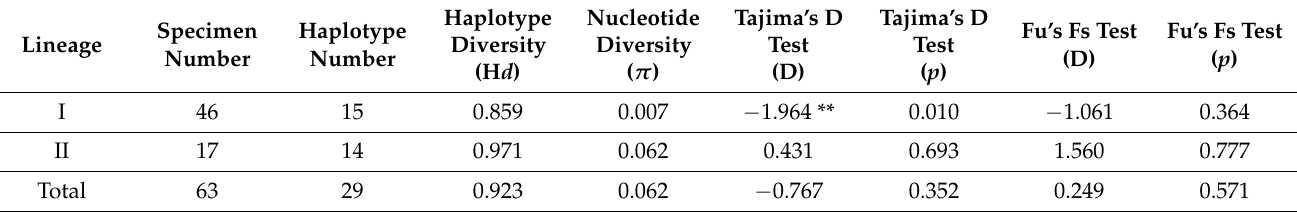
Table 1. Genetic diversity and neutrality test of Lumbriculus variegatus based on the concatenated sequences of gene COI and